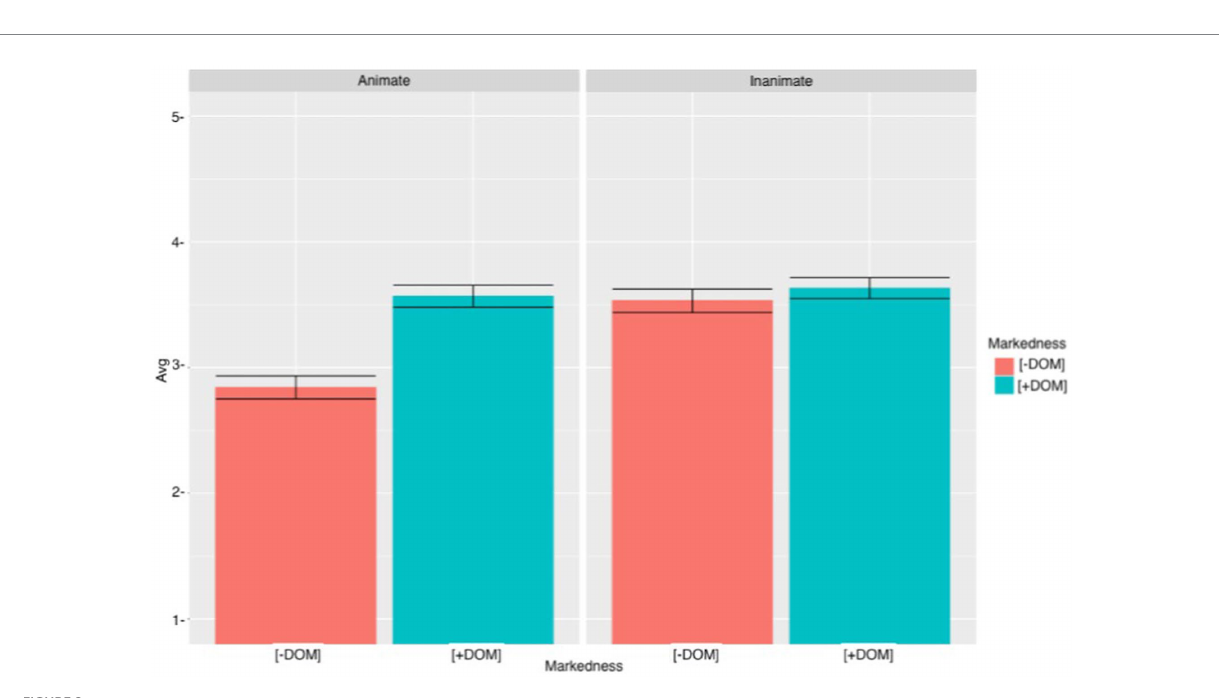
learners’ answers. The cumulative link mixed model for VSO sentences revealed a significant MARKEDNESS effect ( β = 1.40, SE = 0.20, t = − 6.80, p < 0.0001) and a significant ANIMACY effect ( β = 2.24, SE = 0.21, t = − 10.51, p < 0.0001). There was also a significant MARKEDNESS * ANIMACY interaction ( β = − 2.19, SE = 0.29, t = − 7.45, p < 0.0001), a significant ANIMACY *GROUP interaction ( β = − 1.21, SE = 0.27, t = − 4.40, p < 0.0001) and a comparing sentences with inanimate objects with DOM and without